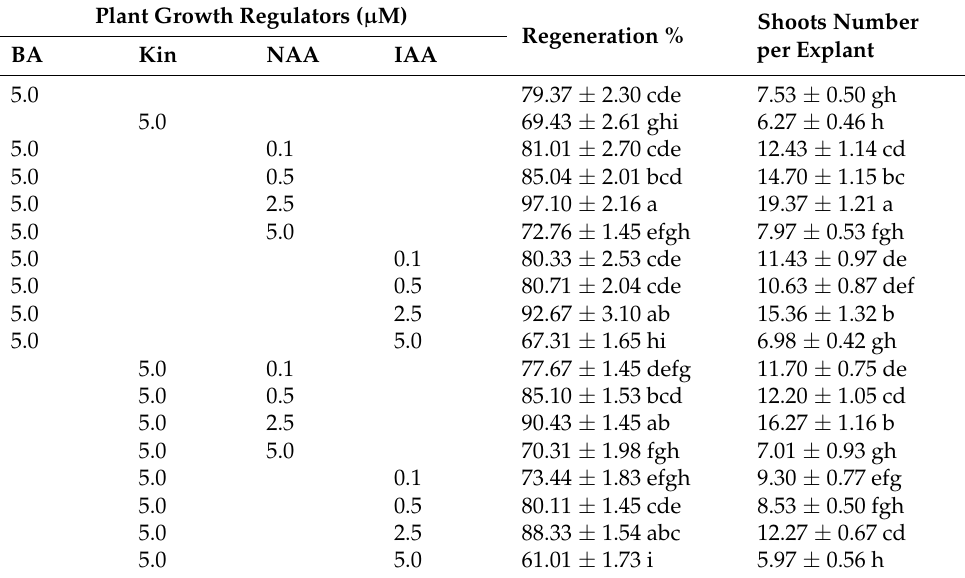
Table 4. Combined effect of 6-benzyladenine (BA) or kinetin (Kin) with α -naphthalene acetic acid (NAA) or indole-3-acetic acid (IAA) on shoot regeneration from axillary node explants of Plectranthus amboinicus